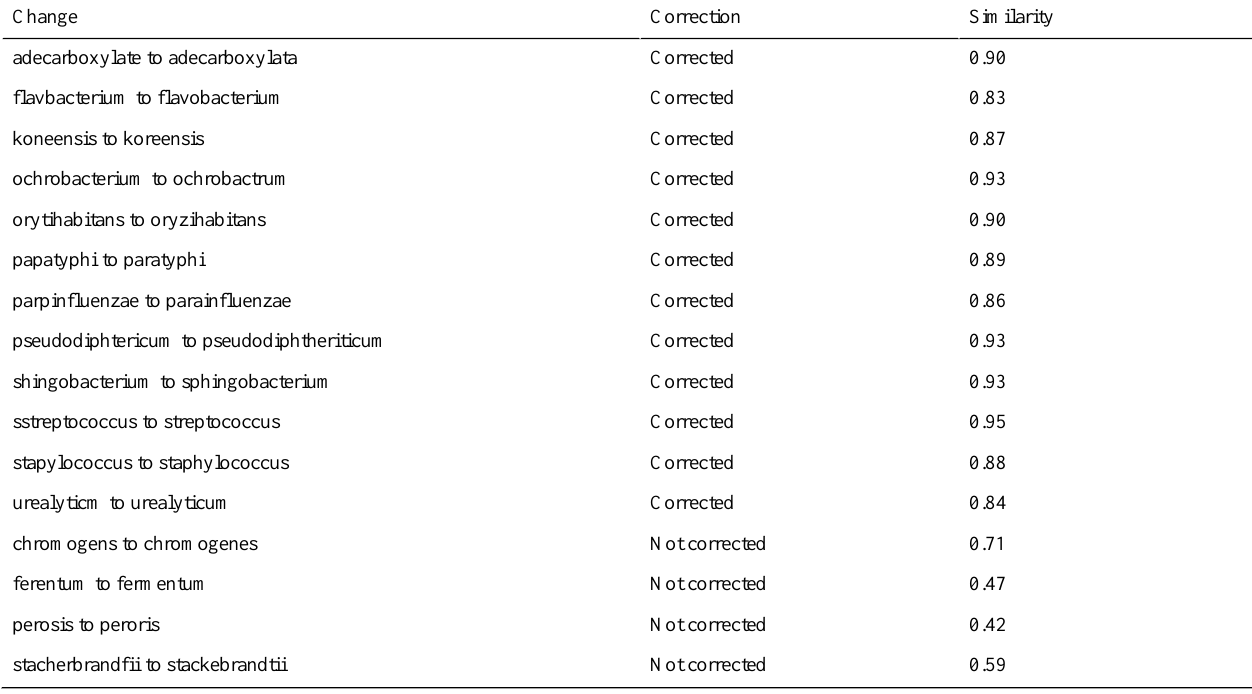
Table 5. Comparison of similarity according to